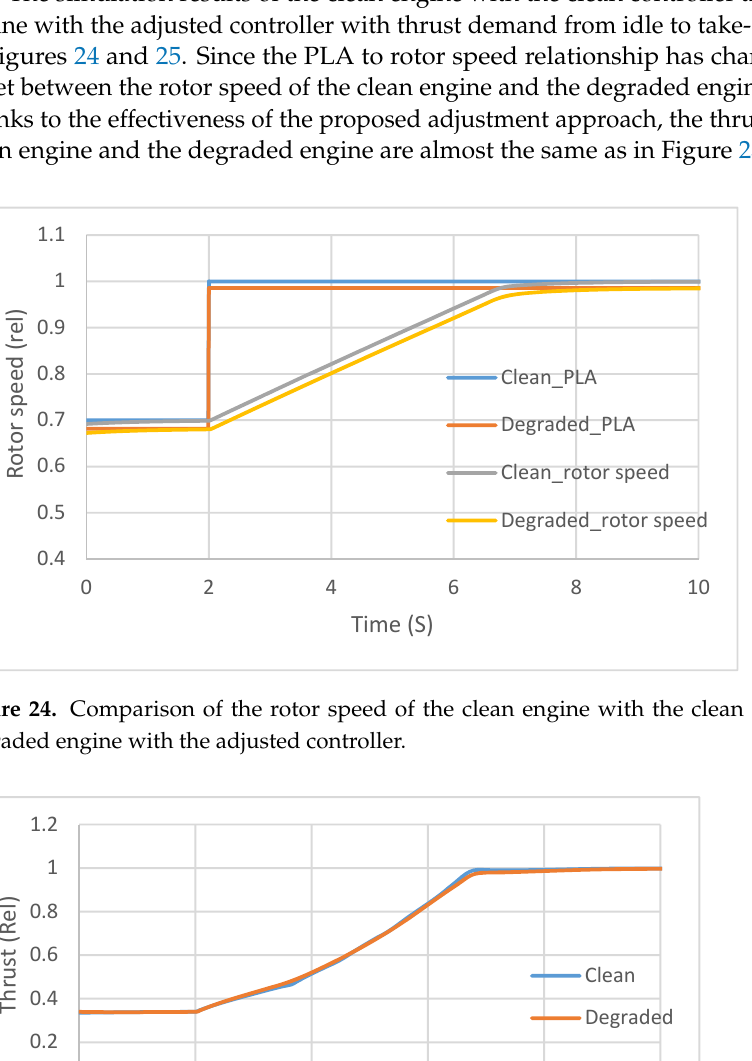
Figure 26. Comparison of the turbine outlet temperature of the clean engine with the clean controller and the degraded engine with the adjusted controller. Apart from the restoration of engine performance, the fuel flow for the degraded en ‐ gine controlled by the adjusted controller is less than the value tuned by the controller before adjustment as in Figure 27. This results in decreasing the fuel consumption as well as the aircraft carbon footprint.